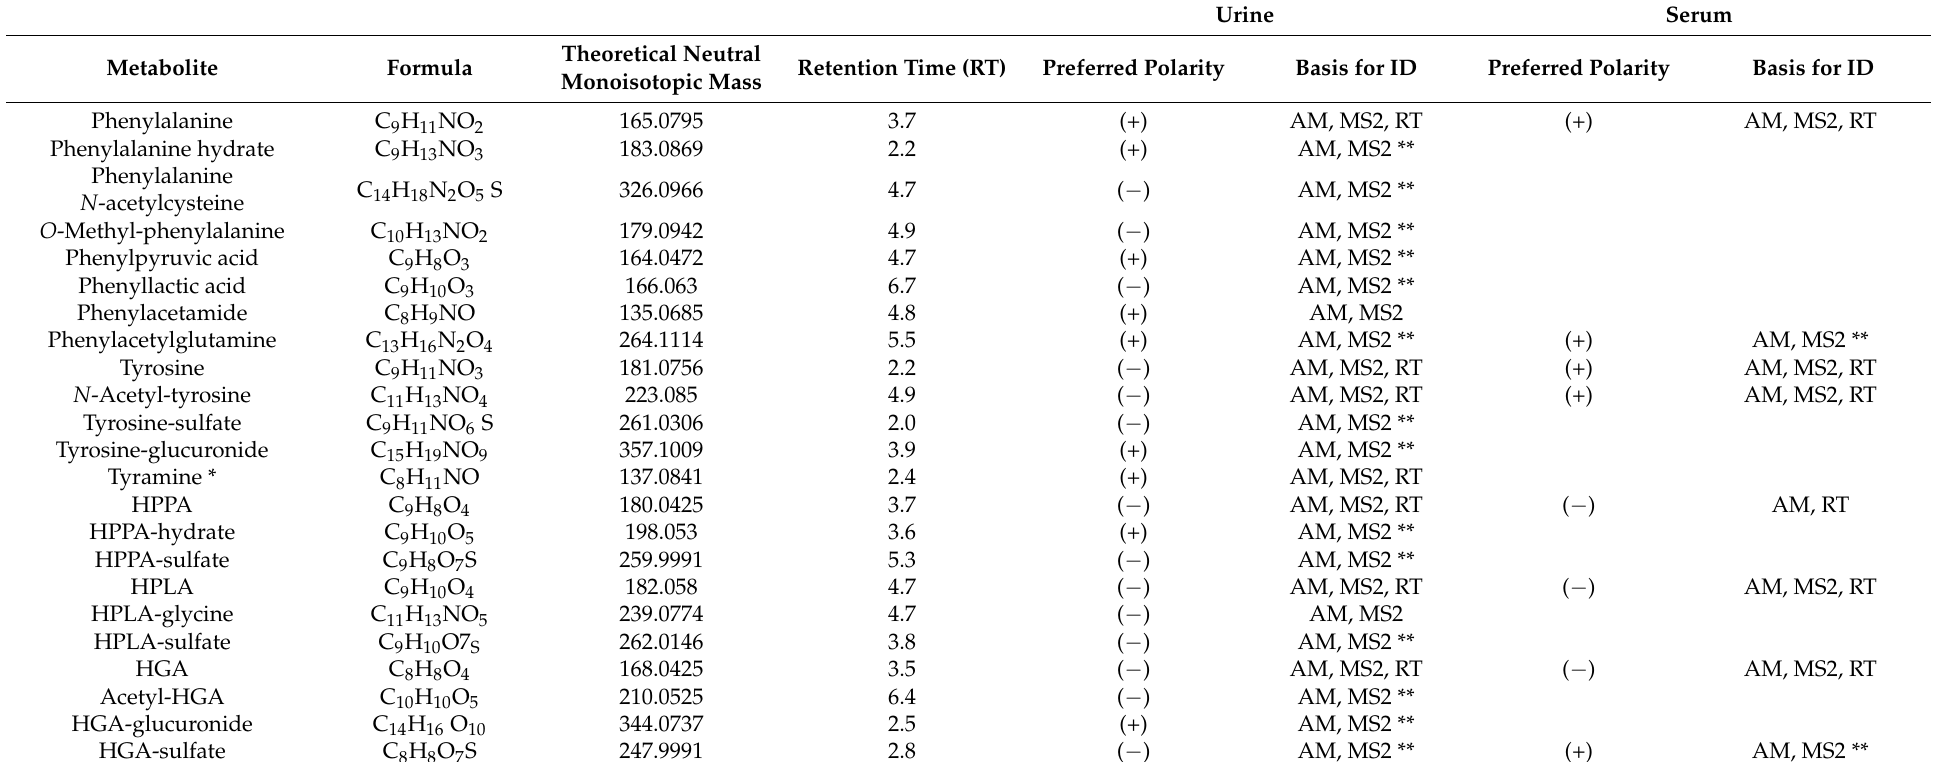
Table 2. Summary of metabolite identifications. All metabolite identifications were made to identification Level 1 according to Metabolomics Standards Initiative guidelines [30], i.e., matches for at least two of the following independent orthogonal chemical properties: accurate mass (AM), tandem mass spectral (MS2) fragmentation pattern and retention time